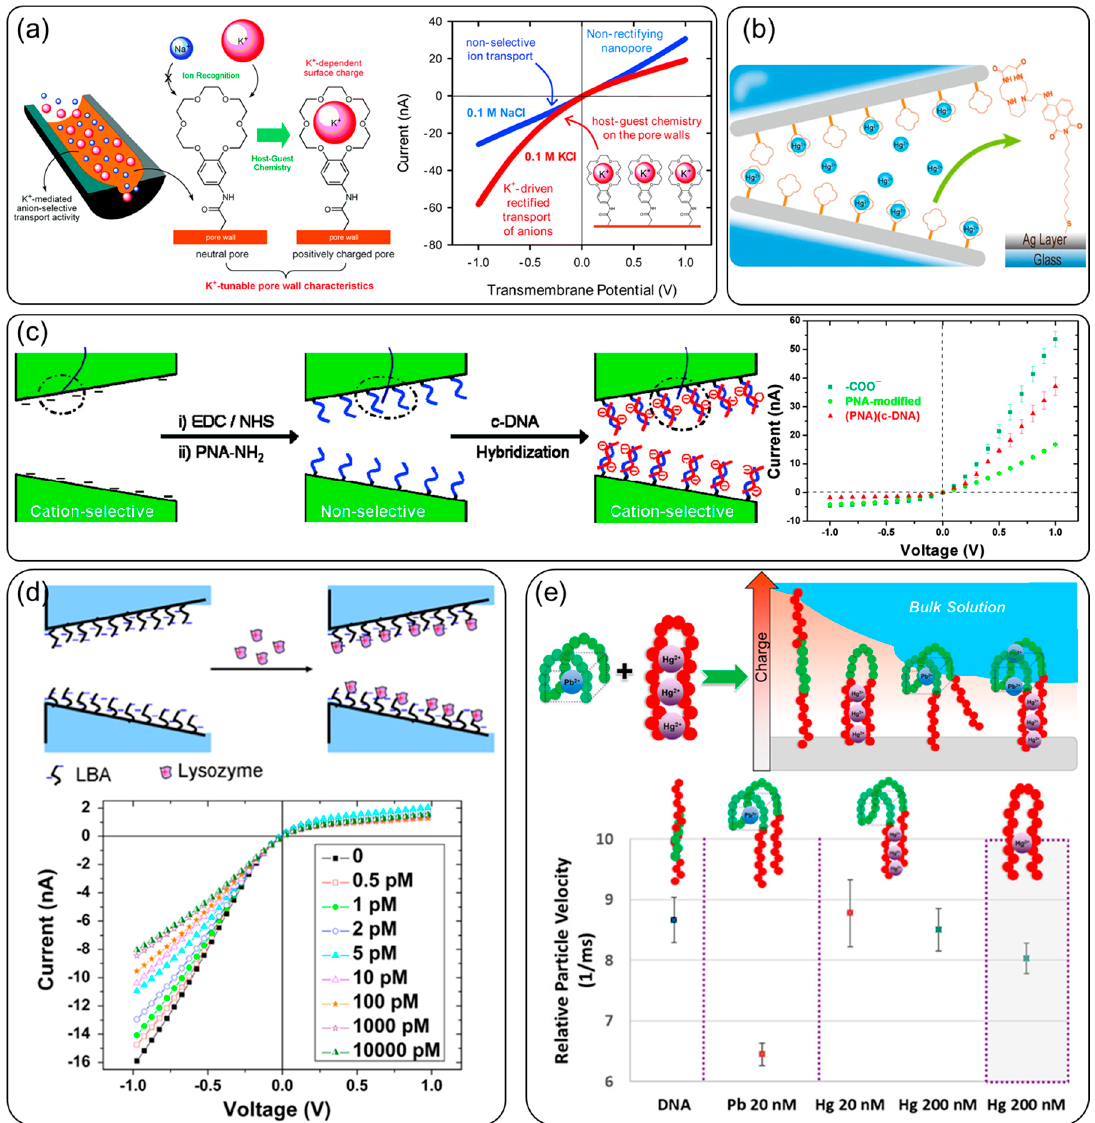
Figure 4. Nanopores for surface charge detection: ( a ) crown ethers chemistry for specific adsorption of K + ions and the current rectification change [90]; ( b ) macrocyclic dioxotetraamine derivative functionalization for Hg 2+ ion determination [91]; ( c ) DNA detection based on PNA – DNA recognition, and the current – voltage ( I–V ) curve change [93]; ( d ) lysozyme detection with aptasensor [94]; ( e ) charged particle detection based on aptamer velocity difference for different heavy metal ions [95].